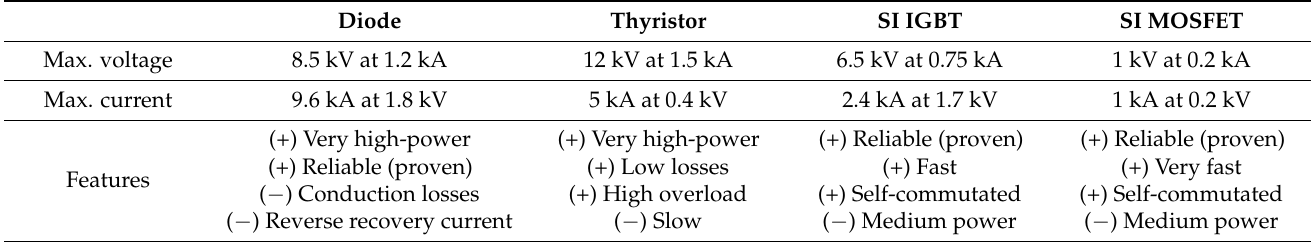
Table 6. Comparison of semiconductor power switching suitable for